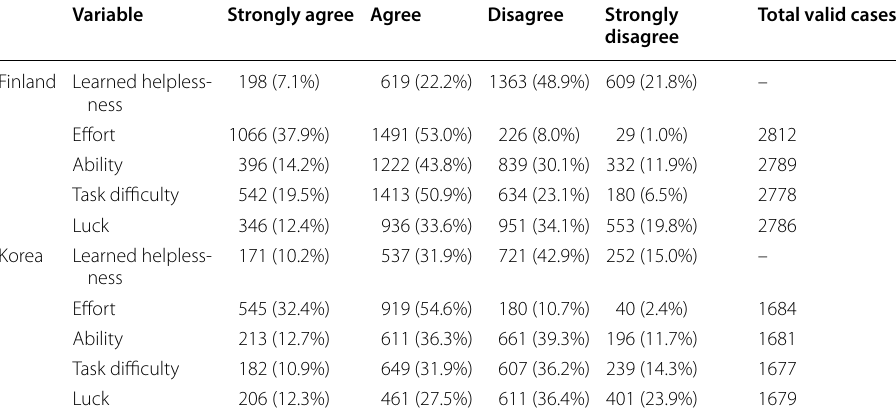
Table 2 The number of Korean and Finnish students for each response to the five